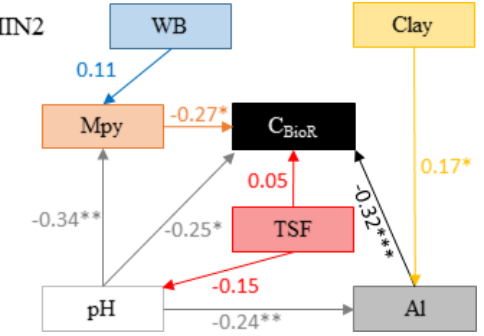
Figure 5. Model that best fitted the data to explain the carbon biore- activity (C BioR ) in the top 35cm of the mineral soil. Arrows indi- cate direct causal relationships. The numbers are standardized av- eraged path coefficients obtained using model averaging (see Table S2 and text for further details). Al: exchangeable aluminum in the top 35cm of the mineral soil; pH: pH of the top 35cm of the mineral soil; TSF: time since fire; Mpy: metal oxide content in the top 15cm of the B horizon; WB: water balance; clay: clay content of the top 35cm of the mineral soil. ∗ p < 0 . 05; ∗∗ p < 0 . 01; ∗∗∗ p < 0 .